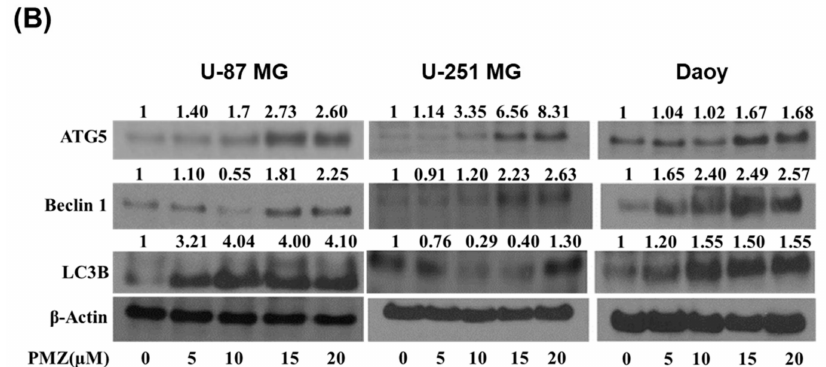
Figure 6. Production of autolysosome by pimozide treatment. ( A ) Approximately 0.2 million Daoy cells were plated in a six-well plate. Daoy cells were treated with 10 µ M of pimozide. After 48 h of pimozide treatment, cells were stained with NucBlue followed by staining with 0.4 µ g / mL acridine orange. Images were taken using a florescence microscope. Blue florescence represents DAPI, whereas red represents the formation of autophagolysosomes. ( B ) Approximately 0.7 million U-87 MG, Daoy, and U-251 MG cells were treated with di ff erent concentrations of pimozide for 48 h. Representative blots show the concentration-dependent e ff ect of pimozide on ATG5, Beclin1, LC3B, cleaved caspase 3, and cleaved PARP expression. β -actin was used as a loading control. Figures shown are the representative blots of at least three independent